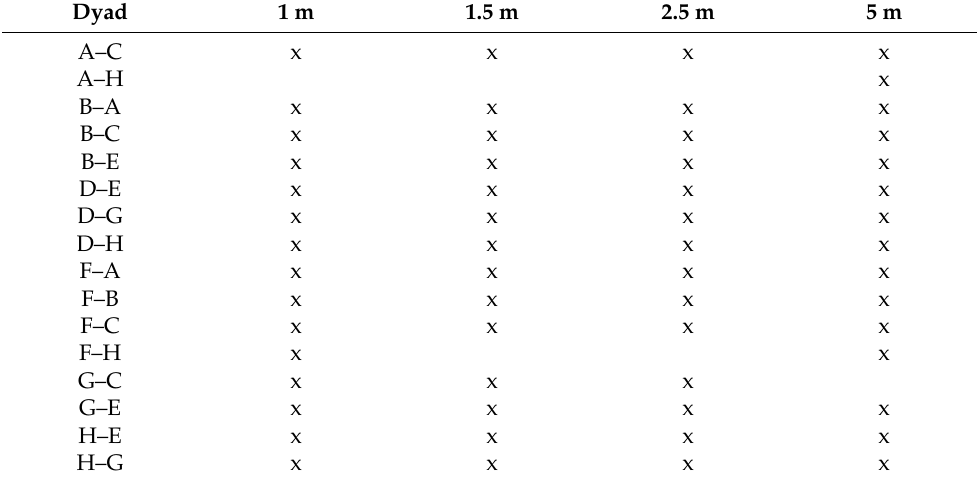
Table A1. Comparison of the social network constructed for the different distance thresholds. An x indicates the presence of an edge (determined association between heifers) in the corresponding network.